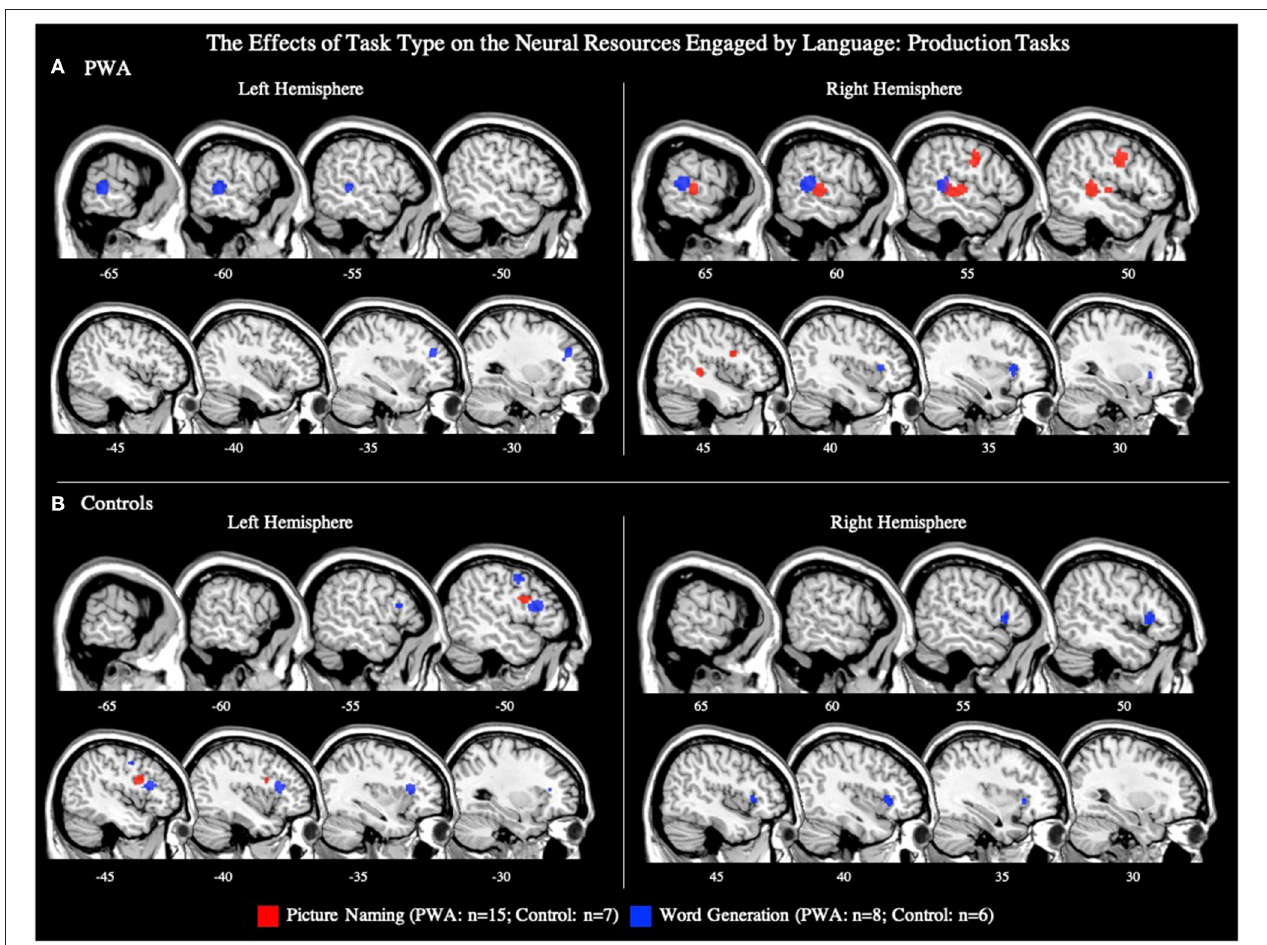
FIGURE 6 | Representative sagittal slices for the picture naming and word generation ALEs in (A) PWA and (B) controls ( p < 0.001 corrected). Sample size denotes the number of tasks included in the